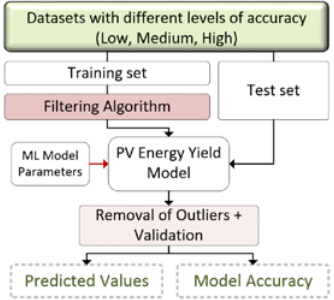
Figure 3. Flowchart for the data processing, including filtering algorithm stage, training, testing, and validation of empirical models and machine learning approaches.